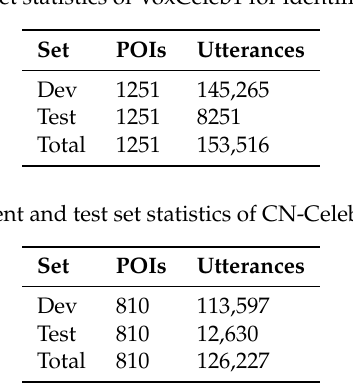
Table 1. Development and test set statistics of VoxCeleb1 for identification. POI, Person Of Interest.